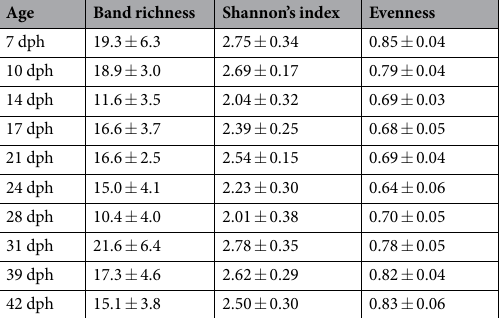
Table 3. Average band richness, Shannon index and Evenness for larval DGGE microbial community profiles at different ages (dph). Error bars are SD for 10